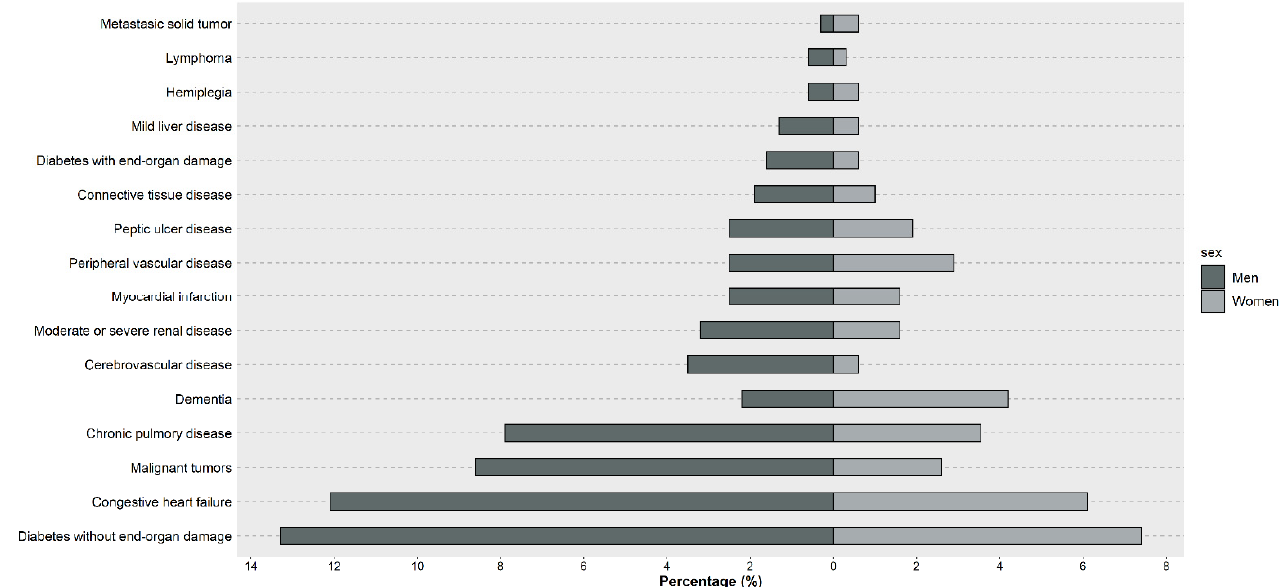
Figure 1. Frequency by sex of comorbidities included in the Charlson comorbidity index among patients with chronic lymphocytic leukemia in Girona, Spain ( n = 400).